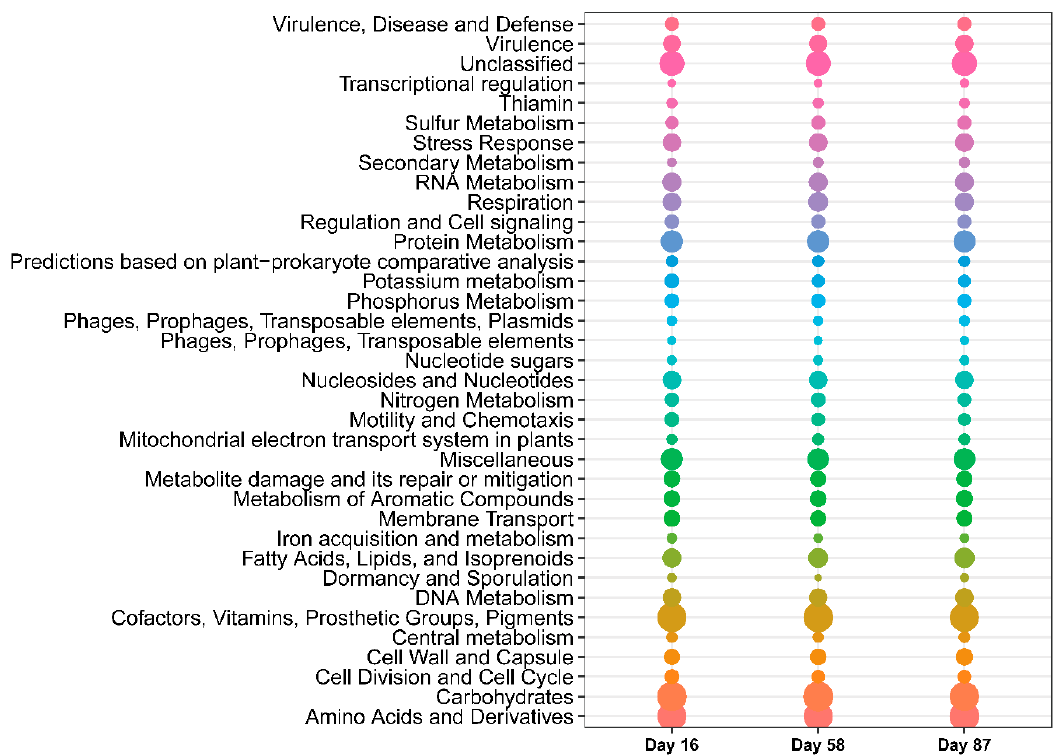
Figure 8. Dynamics of gene expression in the MBR microbial community. Annotation of the metabolic processes of the Day16, Day58, and Day87 samples based on the SEED database for both prokaryotes and eukaryotes.